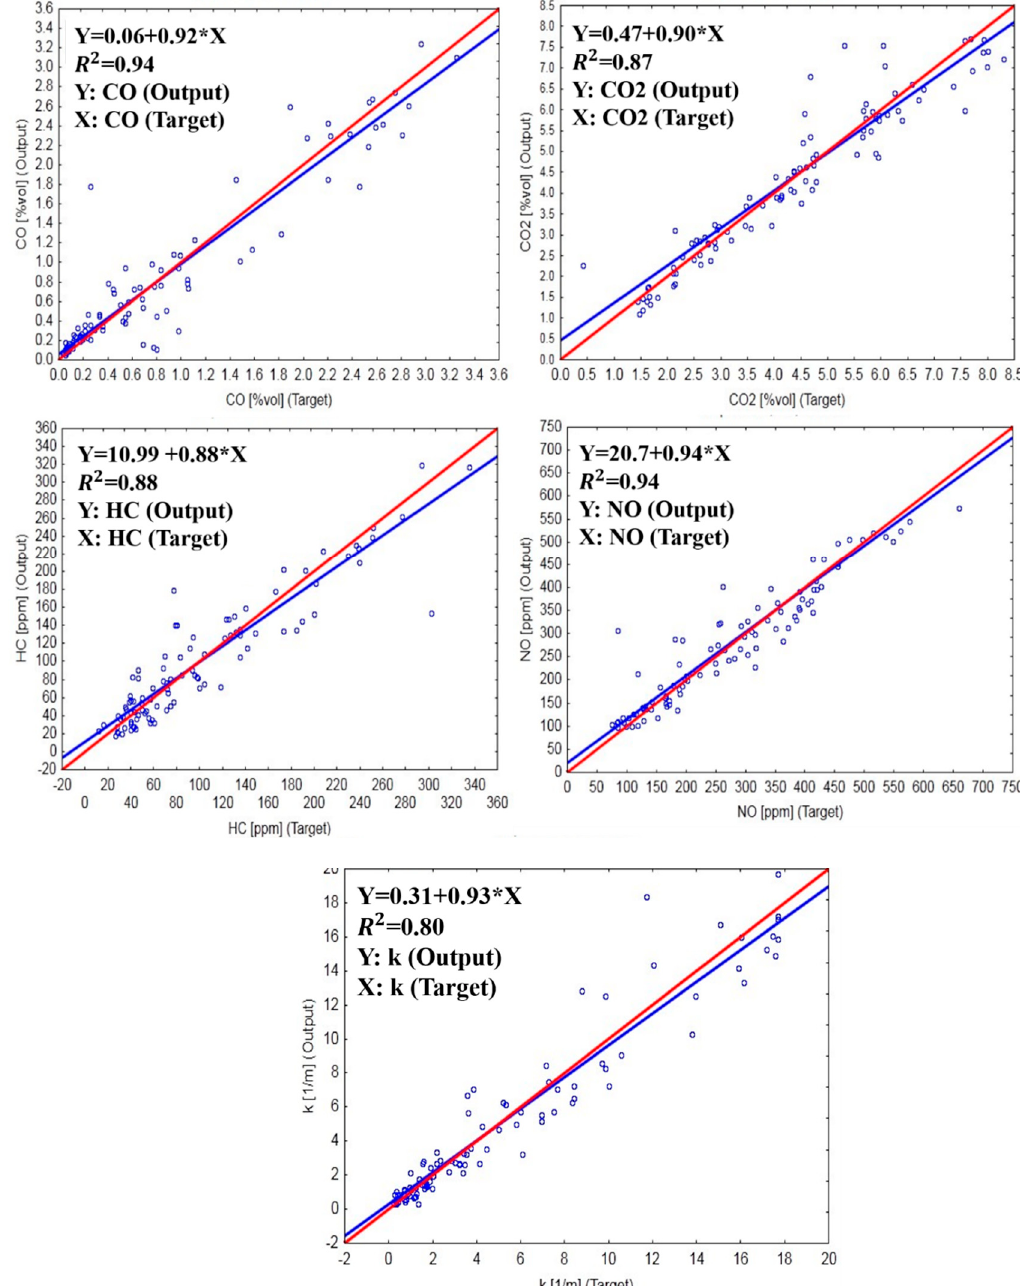
Figure 23. The predicted outputs vs. the measured values for engine emissions (Y: Output of the model; X: Target or experimental data, Red line: 45 degree line e.g., Y = X, Blue line: Fitted line).